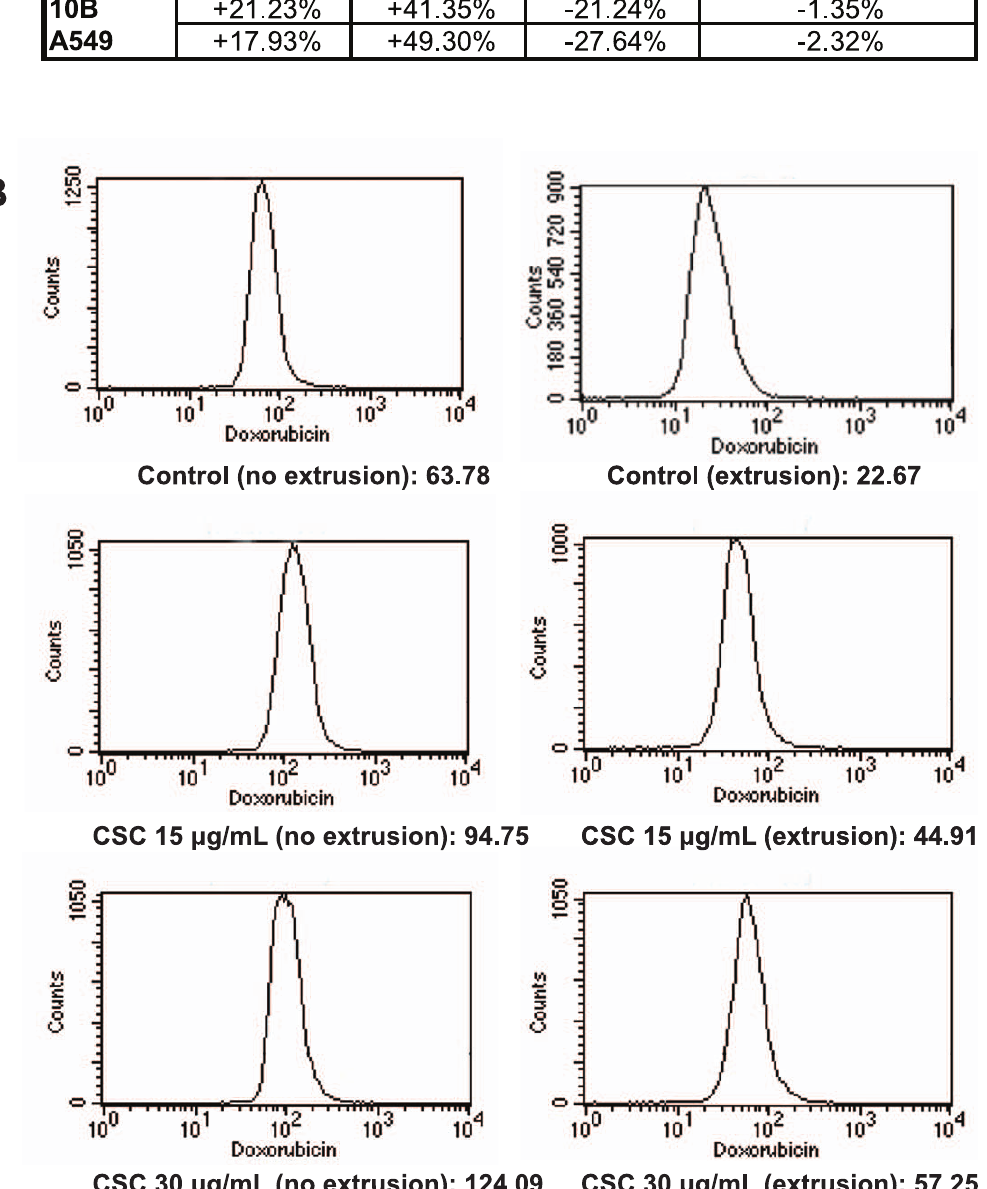
Figure 1. CSC treatment increases doxorubicin efflux in cell lines 10B and A549. ( A ) 15 and 30 m g/mL cigarette smoke condensate (CSC) increases doxorubicin efflux in both cell lines 10B and A549 in a dose-dependent pattern. The specific ABCG2 inhibitor fumitremorgin C (FTC) is able to reverse the CSC-mediated increase in doxorubicin efflux. Percentage change was derived from flow cytometric analysis of median intracellular doxorubicin levels and calculated using the formula described in the methods section. ( B ) CSC increases doxorubicin efflux dose-dependently. Relative efflux gauged by comparing the differences in the median doxorubicin fluorescence channels of extrusion and no extrusion samples. Numerical label reflect the median channel of doxorubicin fluorescence as measured in one sample of flow cytometric analysis of intracellular doxorubicin levels in 10B. Although absolute fluorescence levels in the treated samples are higher due to fluorescence of CSC, the decrease from no extrusion to extrusion is greater for these samples compared to control.